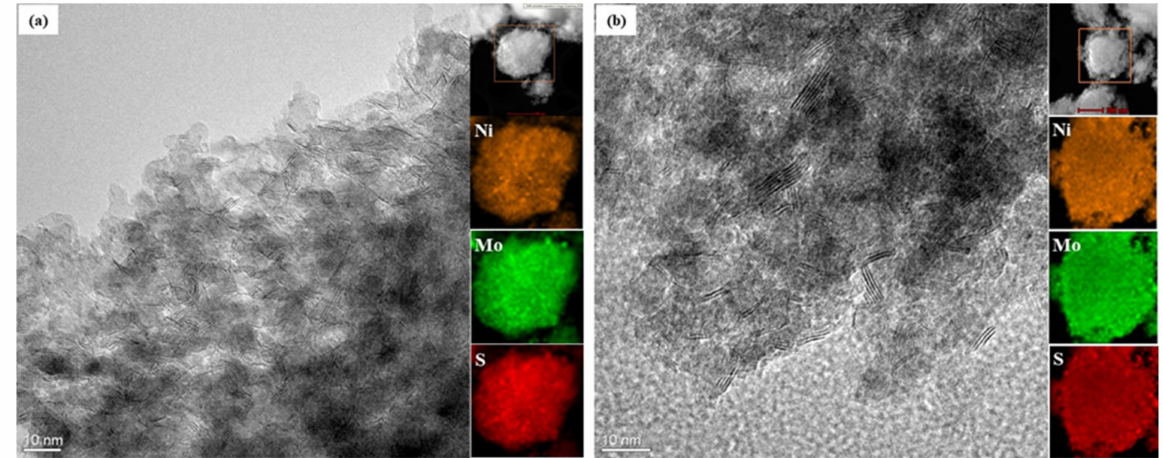
Figure 3. HRTEM images showing the MoS 2 fringes and the elemental distribution of NiMoS/Al 2 O 3 : ( a ) fresh and ( b ) after the 3rd consecutive